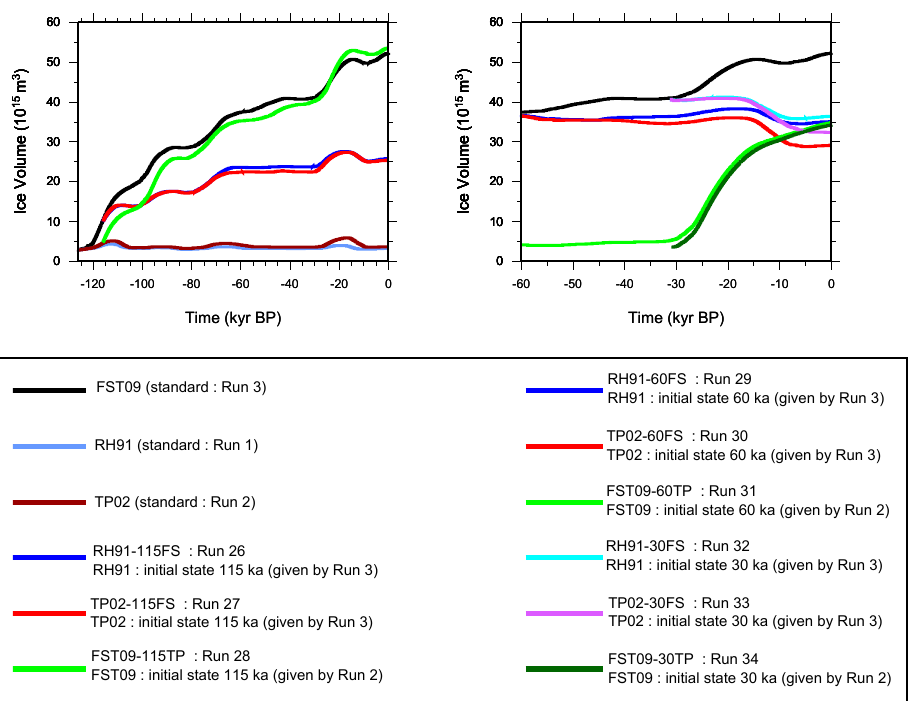
Fig. 7. Simulated ice volumes in runs 26 to 34 (and compared to the ice volumes obtained in the standard experiments: runs 1 to 3) to test the impact of the ice-sheet feedbacks. Different initial conditions are considered at 115ka (left panels) and 60 and 30ka (right panels) with initial ice-sheets given either by the standard FST09 simulation (experiments referring to as Xi-YiFS) or by the standard TP02 simulation